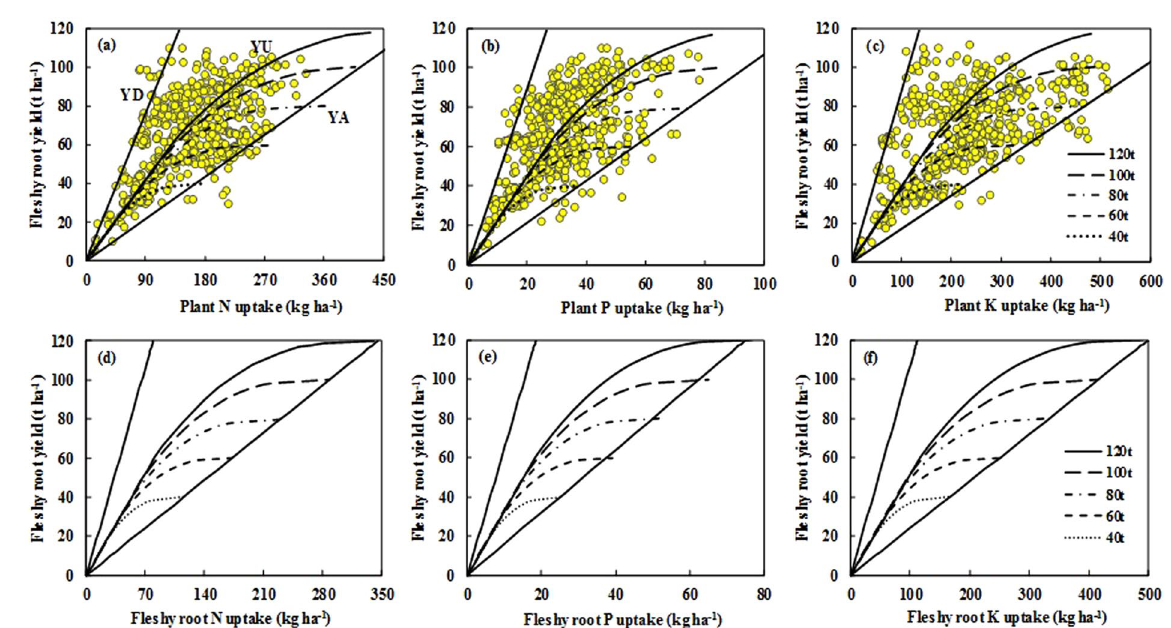
Figure 3. Relationships between fleshy root yield and N, P, and K accumulation in the total plant dry matter at maturity ( a – c ) and fleshy root N, P, and K removal in fleshy root dry matter ( d – f ) under different potential yields predicted by the QUEFTS model. YD, YA, and YU represent the maximum dilution, maximum accumulation, and balanced uptake of N, P, and K in the total plant dry matter or in the fleshy roots dry matter, respectively. These parameters were calculated by the QUEFTS model after excluding the upper and lower 2.5 percentiles of all internal efficiency data (HI ≥ 0.4). The potential yield ranged from 40 to 120 t ha − 1